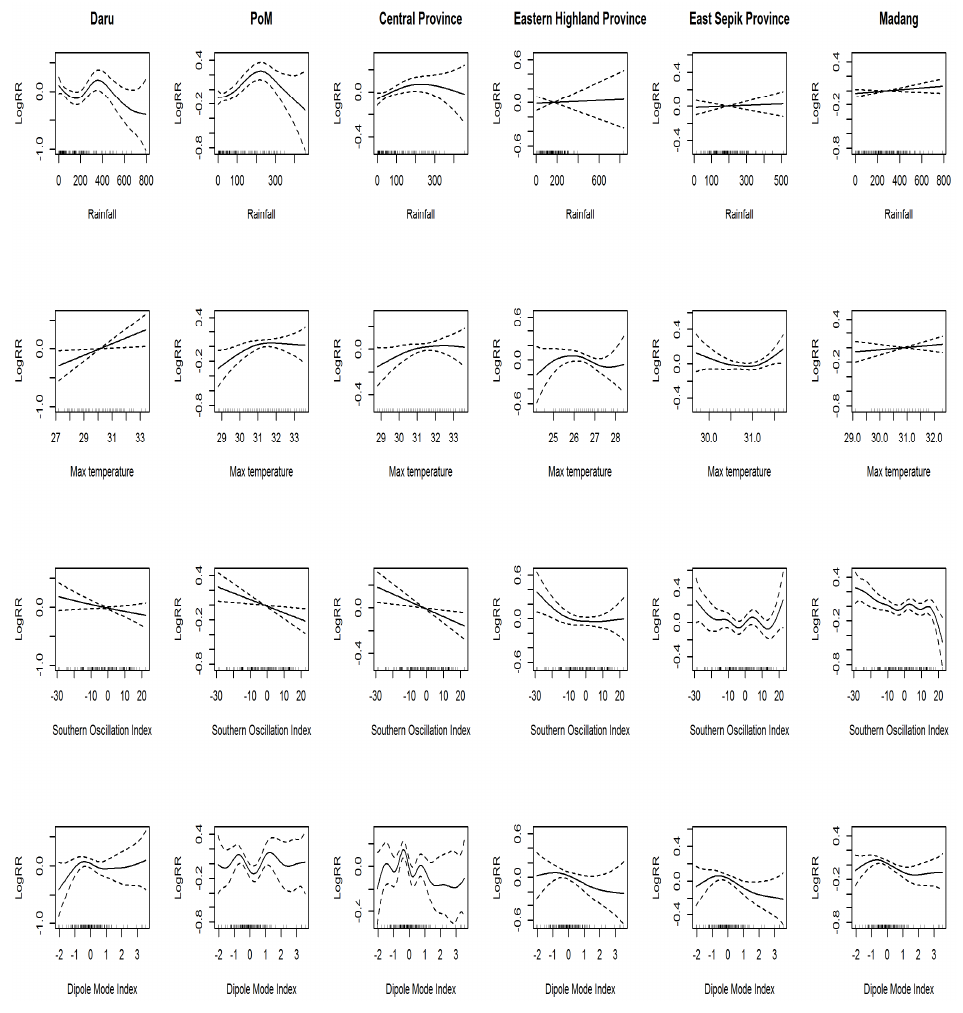
Figure 3. Log(RR)s of independent variables using a generalized additive model in six geographic areas in Papua New Guinea.